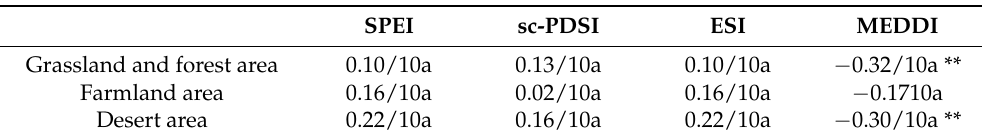
Table A1. Temporal trends of SPEI, sc-PDSI, ESI and MEDDI in the grassland and forest area, farmland area and desert area, over